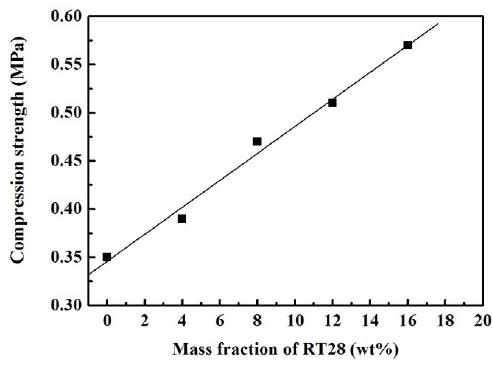
Figure 5. Relation between the compression strength of the cubes and the mass fraction of RT28.